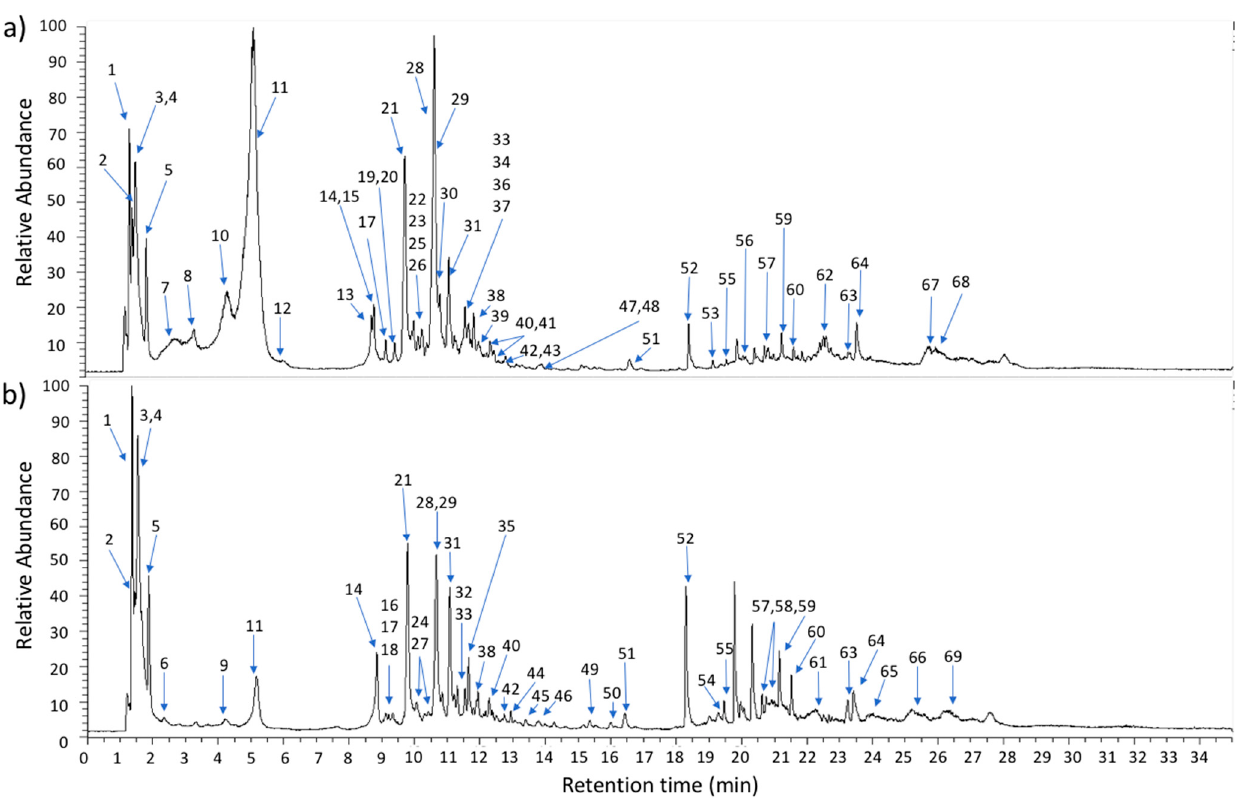
Figure 1. Ultra-high-performance liquid chromatography (UHPLC) chromatogram of Coryphantha macromeris methanolic extracts prepared with aerial ( a ) and radicular ( b ) parts. Peak numbers refer to the metabolites indicated in Table 1; repeated numbers in ( a ) or ( b ) indicate that the metabolite is found in both plant